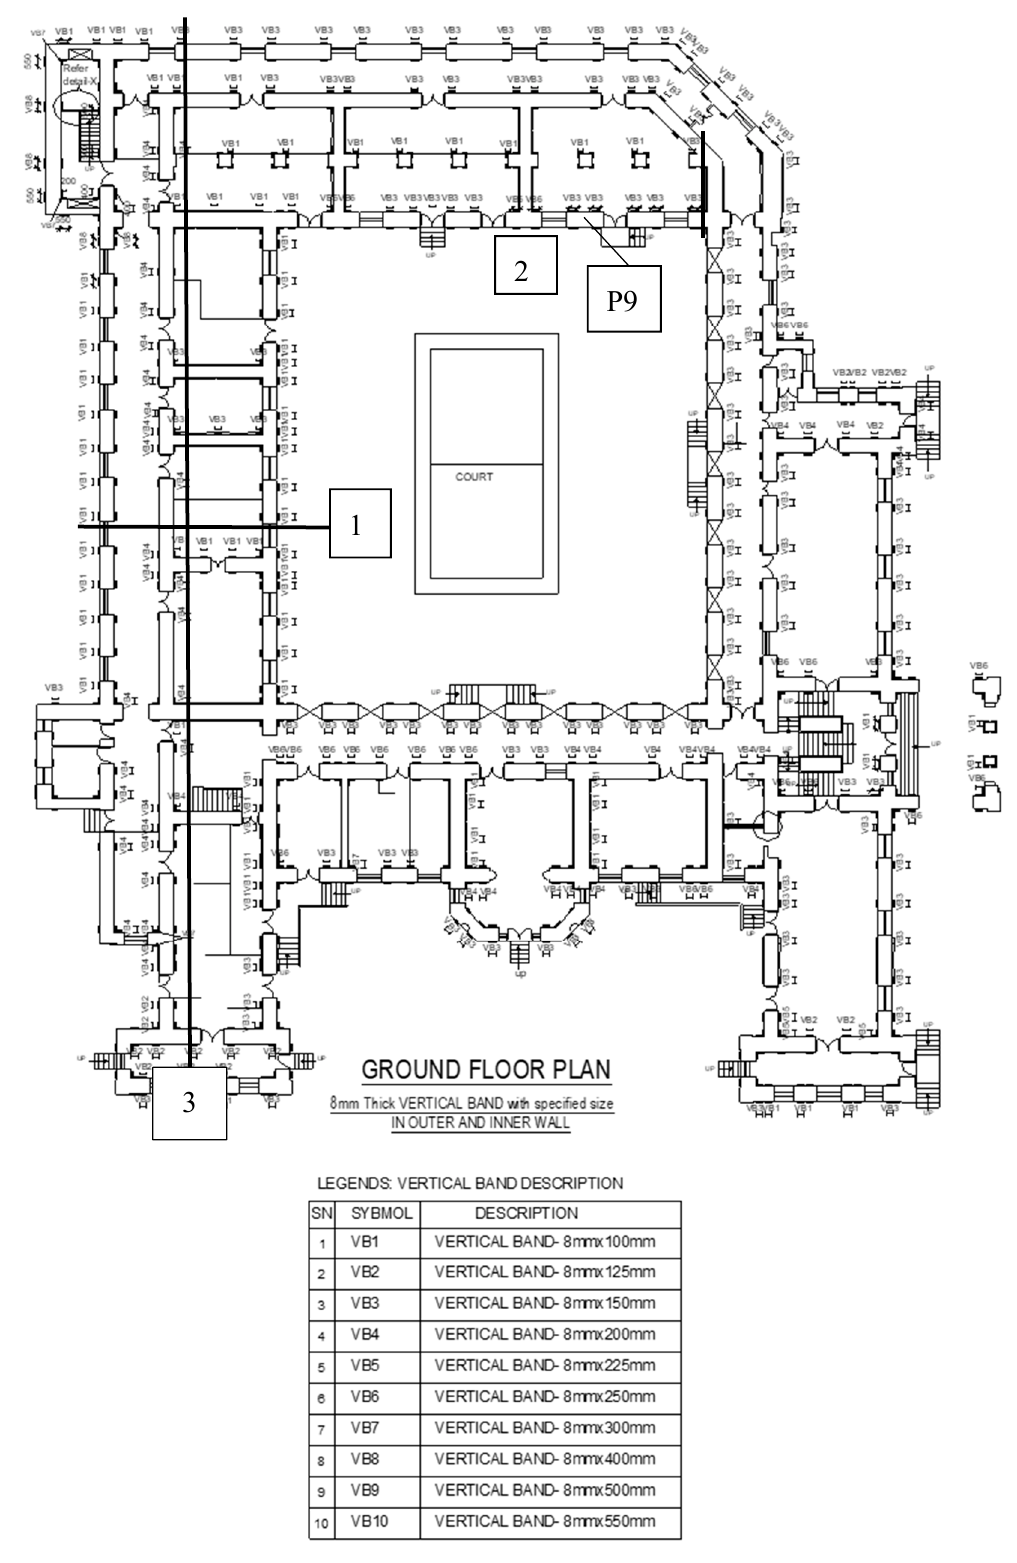
Figure 10. Retrofitting measures adopted for the monument (line and text in box indicates section-cut number and pier number).